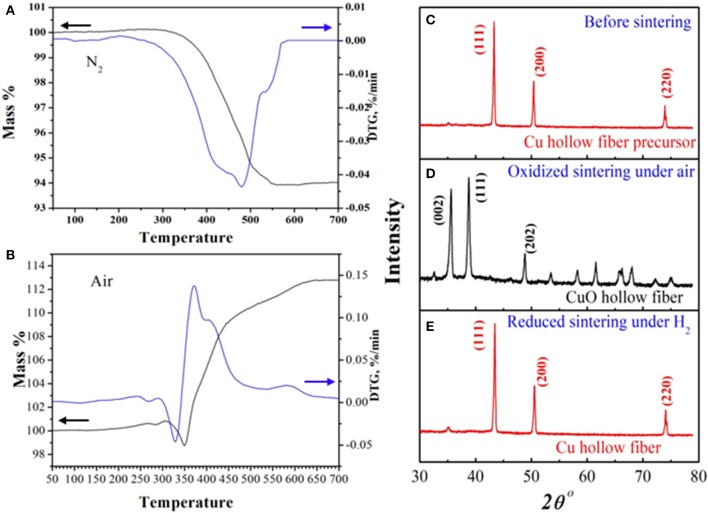
TGA curves of the Cu HFMs precursor in (A) N2 and (B) air atmospheres; XRD patterns of the (C) Cu hollow fiber precursor, (D) CuO hollow fiber and (E) Cu hollow fiber.